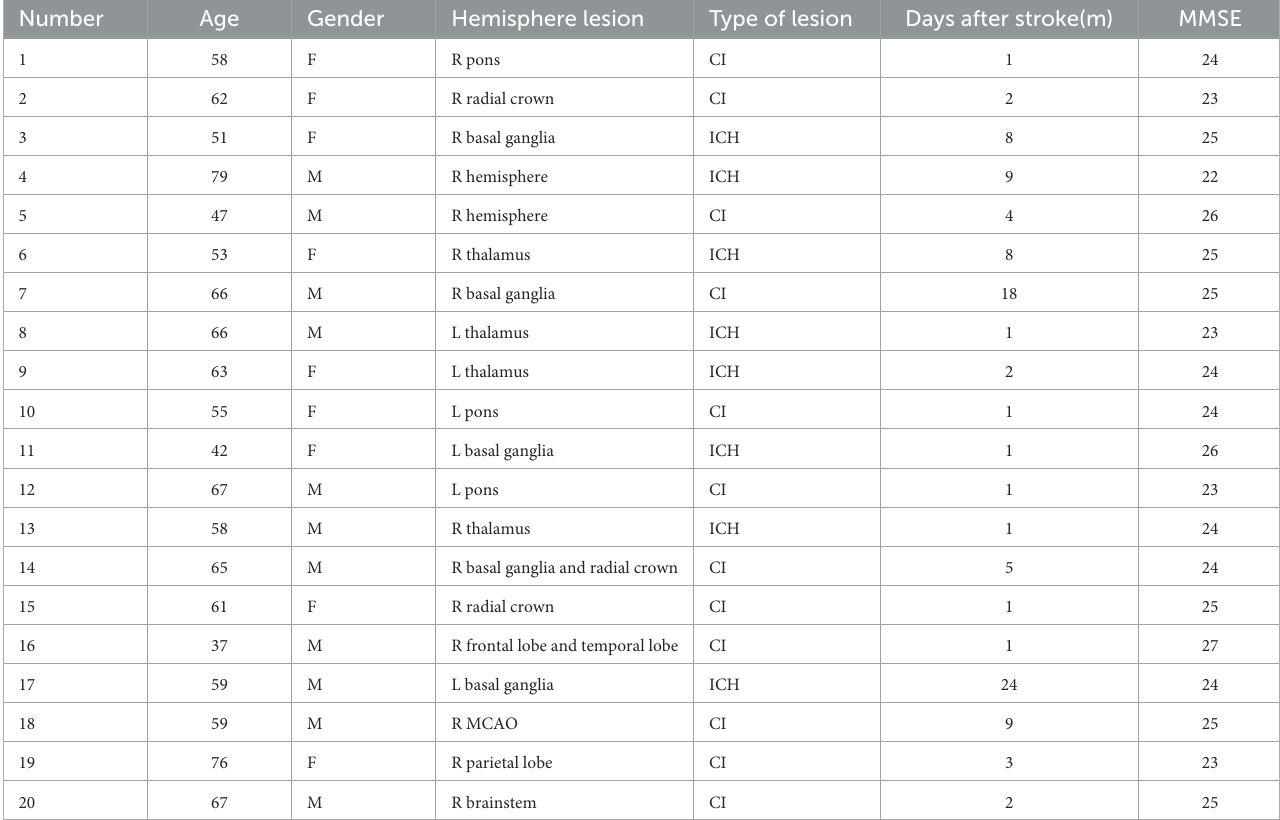
TABLE 1 Demographics and clinical properties of the